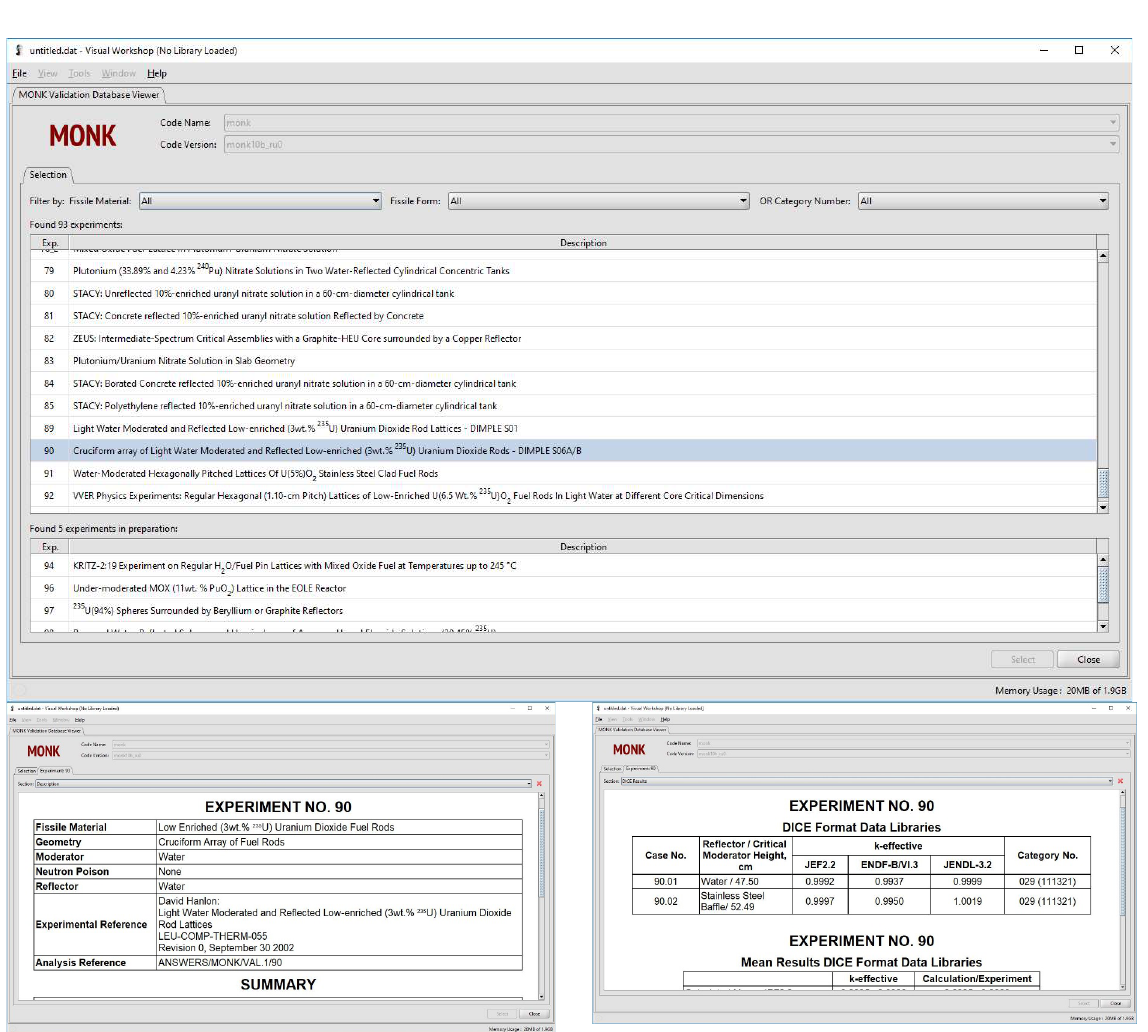
Figure 4. Screen Shots from the Validation Database